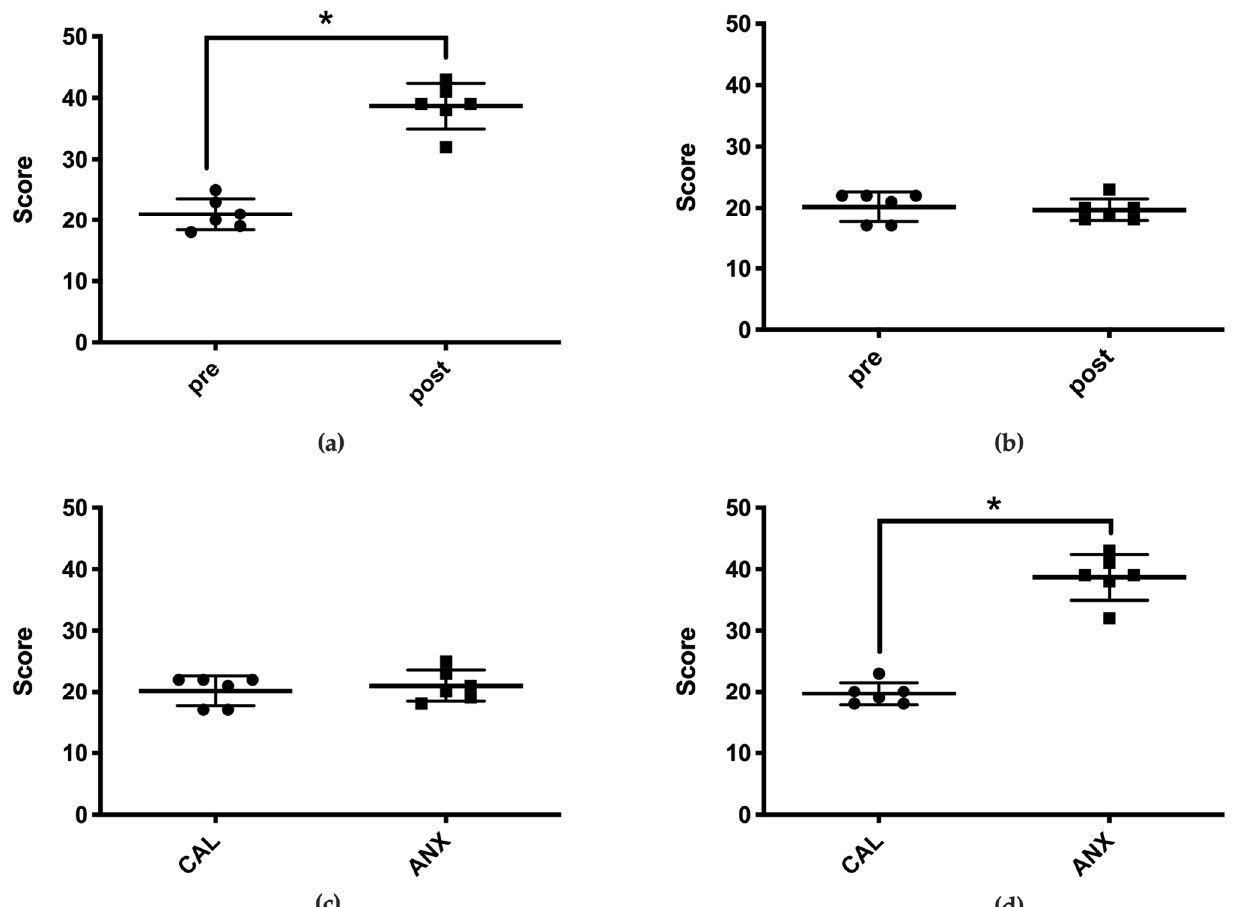
Figure 2. Each circle and square indicate the total behavioral evaluation score of each cat. The thick horizontal lines and error bars represent the six medians and ranges. The “pre” on the horizontal axis denotes the total behavioral evaluation score before environmental acclimatization, and the “post” denotes the total score after environmental acclimatization. “CAL” and “ANX” on the horizontal axis refer to their respective groups. * Indicates statistical significance. The graphs depict the following: ( a ) the pre- and post-environmental acclimatization behavioral evaluation scores in the ANX group; ( b ) the pre- and post-environmental acclimatization behavioral evaluation scores in the CAL group; ( c ) the pre-environmental acclimatization behavioral evaluation scores in both groups; ( d ) the post-environmental acclimatization behavioral evaluation scores in both groups. * Significantly different between groups ( p < 0.05)